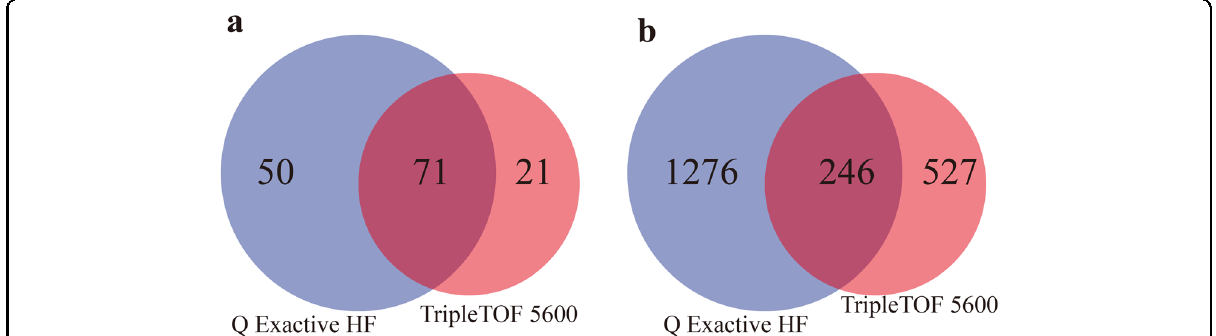
Fig. 4 Analysis of peptidomics data of C. betulinus venom by two different mass spectrometry (MS) systems. a Numbers of identi fi ed proteins. b Numbers of identi fi ed peptides.